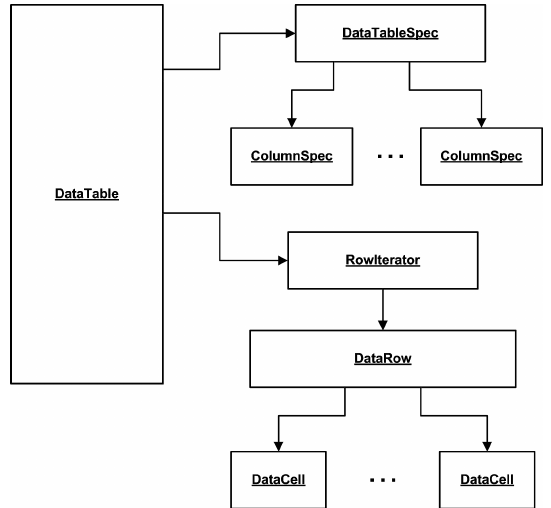
Fig. 4. A UML diagram of the data structure and the main classes it relies on.